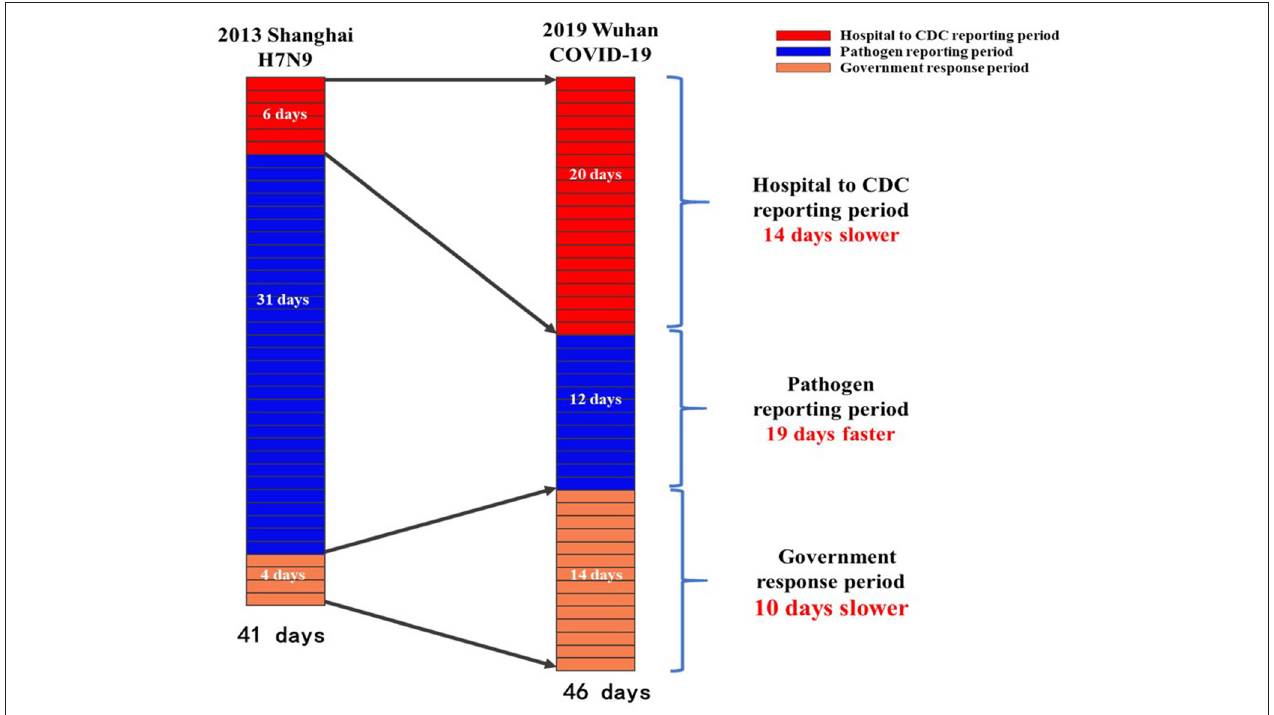
FIGURE 2 | Comparison of three critical emergency disposal speed between H7N9 avian influenza (2013) in Shanghai vs. coronavirus disease 2019 in